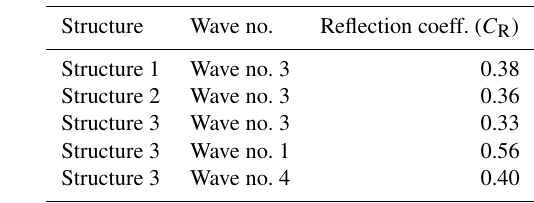
Table 5. Calculated reflection coefficients.